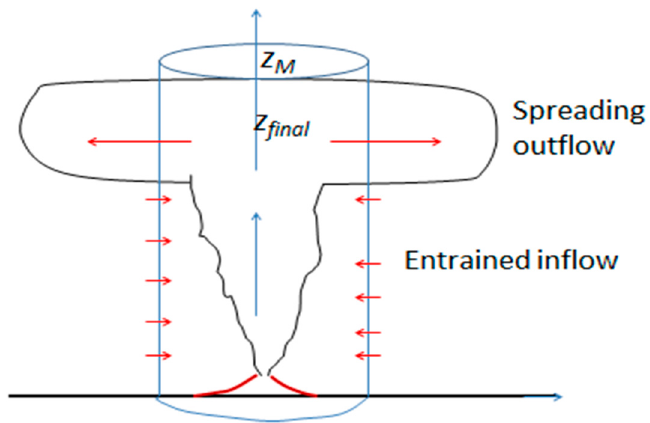
Figure 1. Schematic model of the horizontal velocity field on a circular cylinder surrounding a turbulent plume, as the model for an eruption. The flow consists of an upper level spreading zone centred on the level z final , with entrained inflow below.